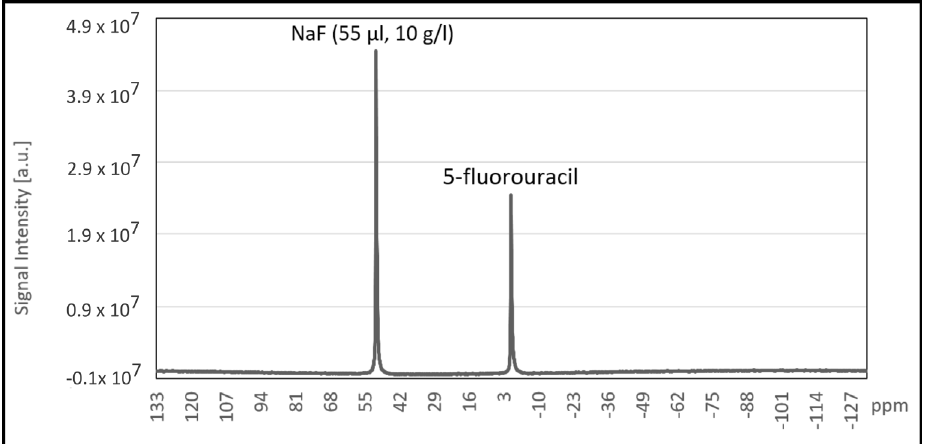
Figure 4. 19 F spectroscopy of the suspension of 5-FU loaded nanocarriers .